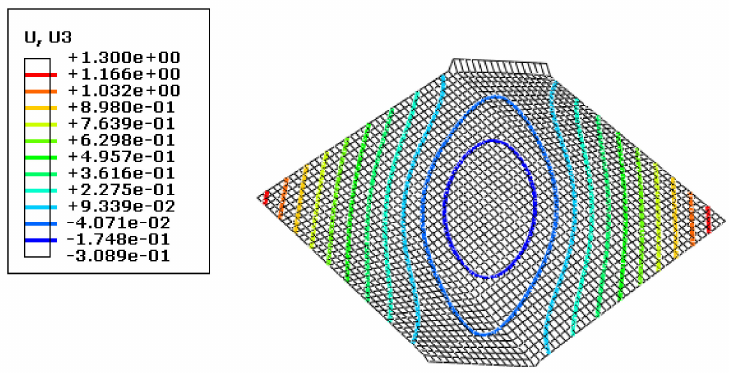
Figure 10. Deformation nephogram using the dynamic algorithm with a grid size of 2